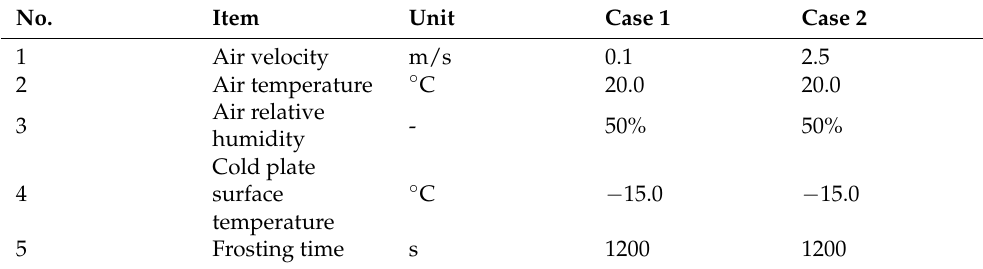
Table 1. Experimental